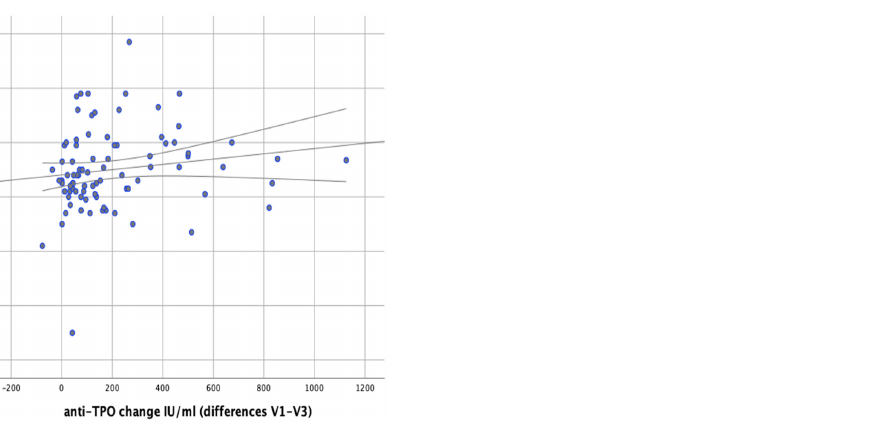
Figure 14 . Correlations between differences in BMI and changes in serum anti-TPO levels in the women studied (between initial visit V1 and final visit